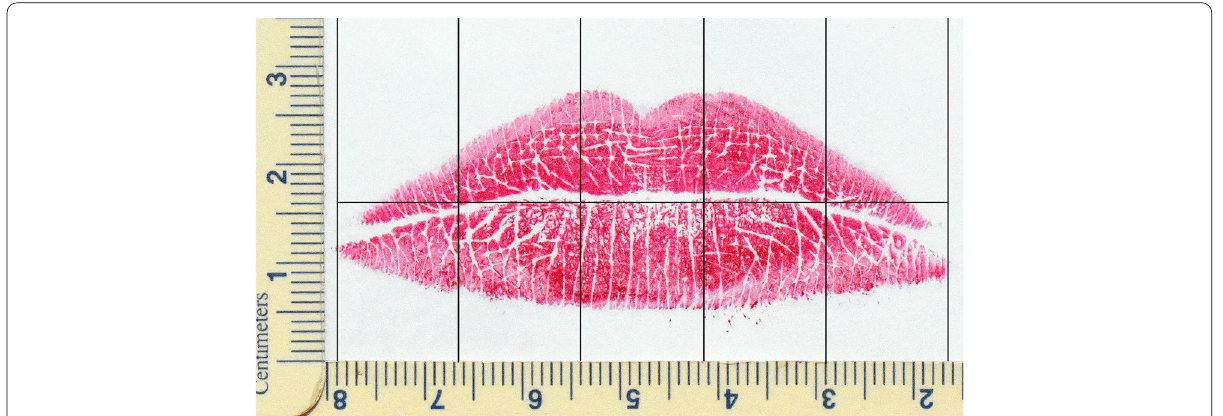
Fig. 1 Image showing the division of a lip print sample into ten quadrants. Quadrants from top-left to right: ULR, UMR, UC, UML, ULL; Bottom-left to right: LLR, LMR, LC, LML, LLL